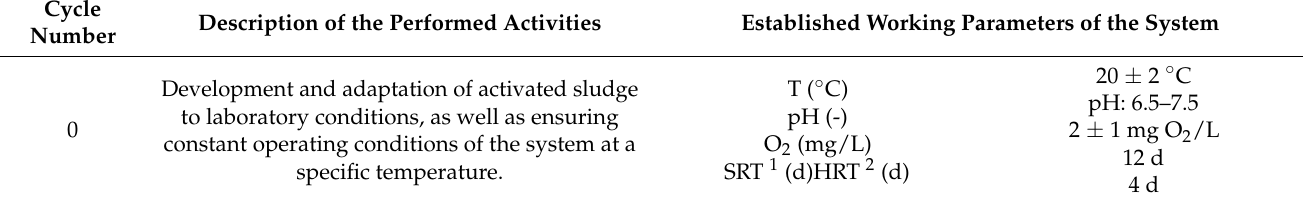
Table 1. Description of individual research cycles of the SBR reactor